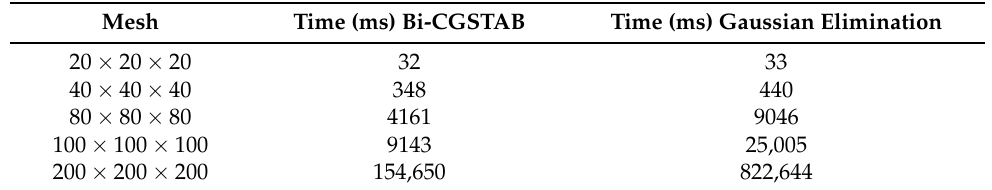
Table 2. Comparison of the algorithm computation times depending on the method used to solve the system of